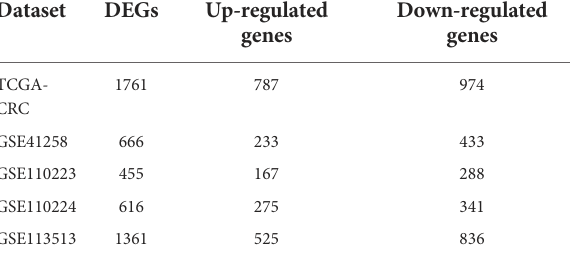
TABLE 2 The number of DEGs in each dataset.